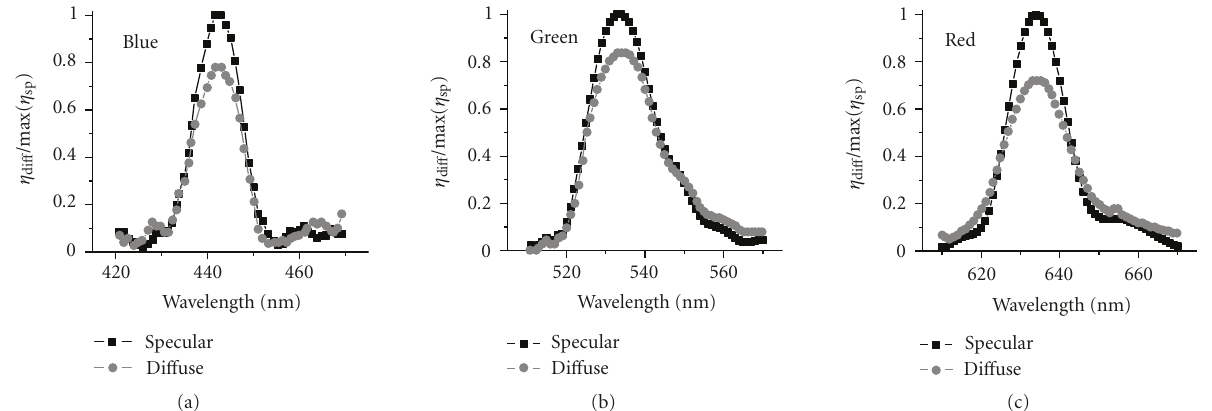
Figure 5: Spectral dependence of di ff raction e ffi ciency in recording of specular ( η sp ) and di ff usely reflected objects ( η di ff ) in red, green, and blue spectral regions.